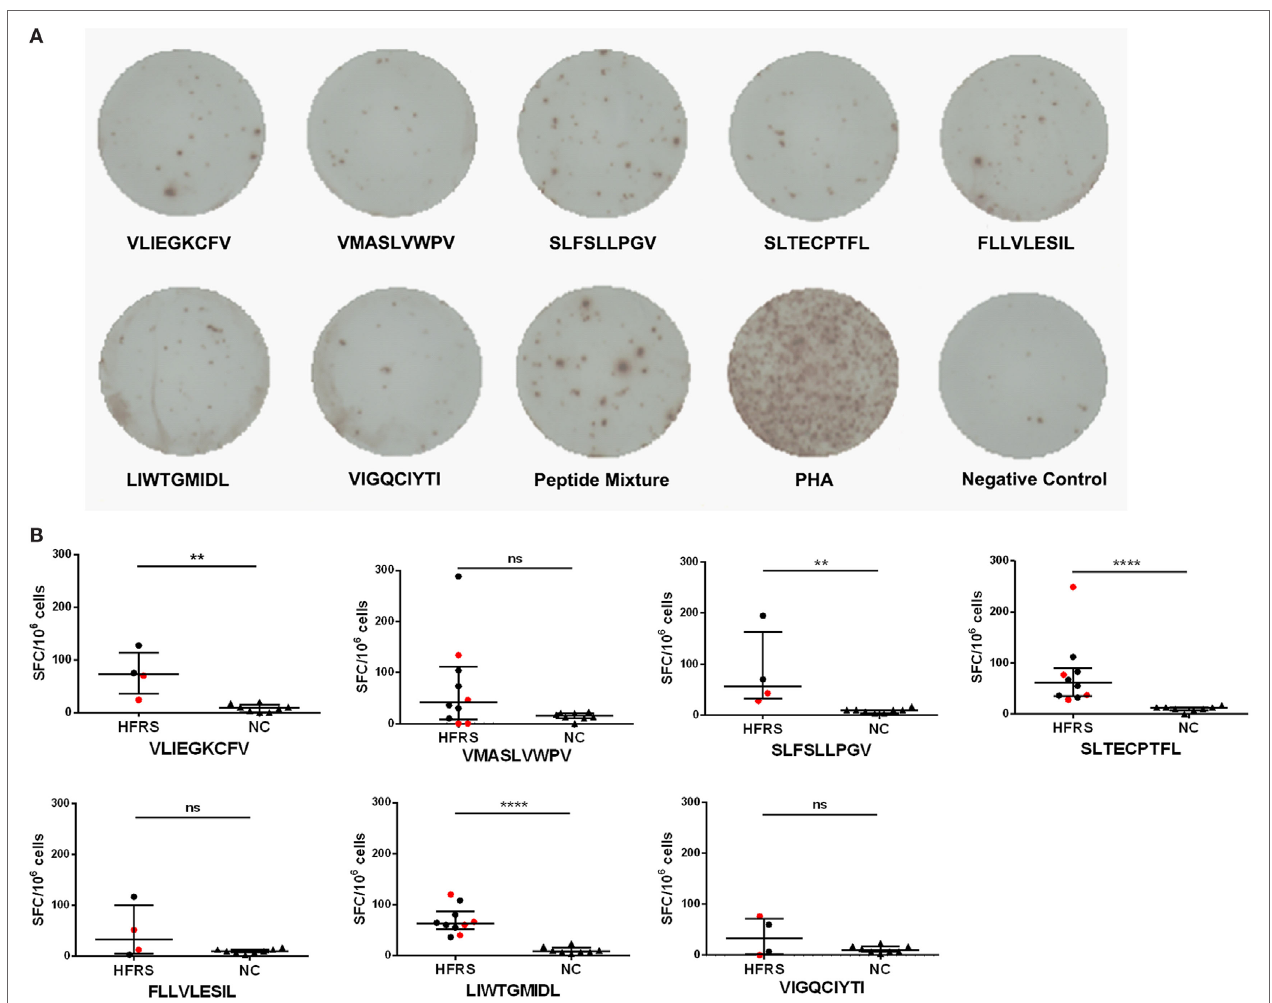
FigUre 3 | Detection of Hantaan virus (HTNV) glycoprotein (GP) epitope-specific CTL responses in patients with hemorrhagic fever with renal syndrome (HFRS). An ex vivo IFN- γ enzyme-linked immunospot assay was used to test the epitope-specific IFN- γ -producing CTLs of patients with HFRS. (a) The peripheral blood mononuclear cells of HLA-A*02 + patients with HFRS (a 47-year-old male with moderate disease severity) were stimulated with 40 µmol/L single peptide or peptide mixture or 10 µg/mL phytohemagglutinin (PHA) in vitro. The notes under the wells indicate the sequences of peptides or the name of the stimulant. Cells stimulated with PHA served the positive control, and cells with no stimulation were the negative control. (b) Comparison of the numbers of spot-forming cells (SFC) between HFRS patients and HLA-A*02 + healthy donors [normal controls (NC)]. The black dots represent patients with mild/moderate disease severity and the red dots represent patients with severe/critical disease severity. The numbers of epitope-specific INF- γ -secreting SFC were calculated by subtracting the numbers of spots in the negative controls from those in the stimulated samples. The Mann–Whitney U test was used to determine the significance of differences between two groups, and black lines represent the medians with the corresponding interquartile ranges. p -Values below 0.05 ( p < 0.05) were considered statistically significant, ** p < 0.01, **** p < 0.0001, ns indicates no significant